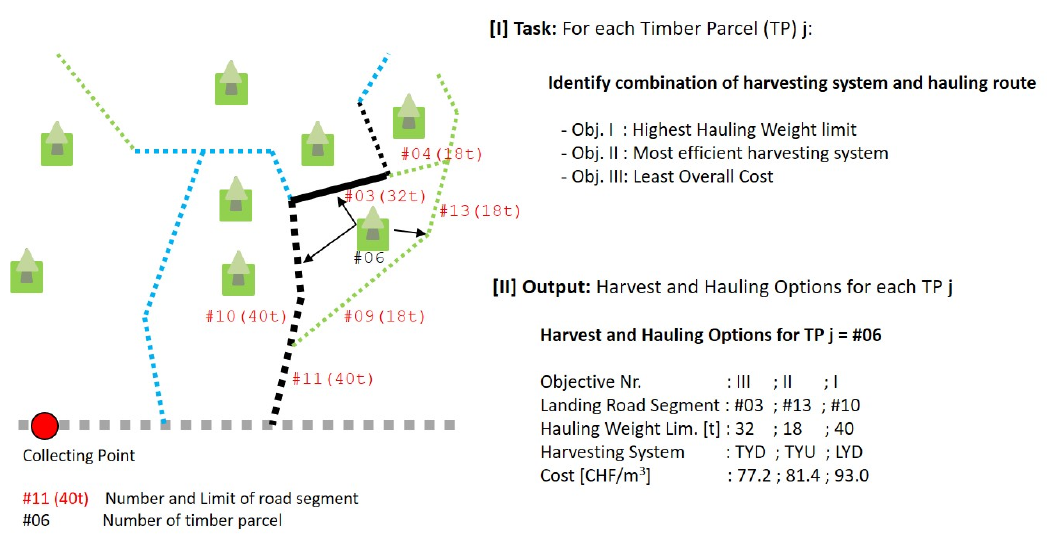
Figure 4. Task and output of the model subsystem “heuristic optimization”, which evaluates favorable combinations of harvesting options and hauling routes for each timber